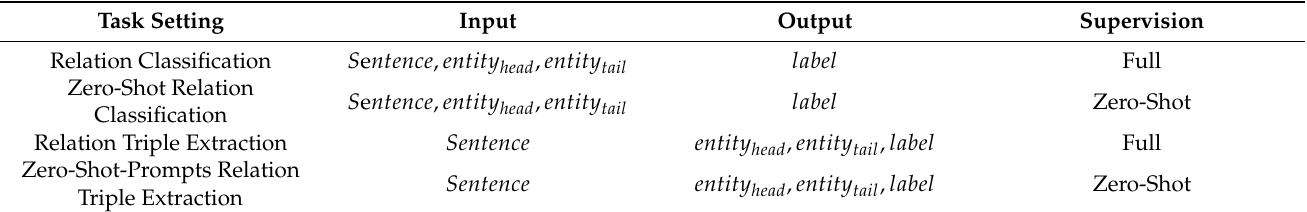
Table 2. Task parameters against our proposed Zero-Shot prompts retreated to triplet extraction.